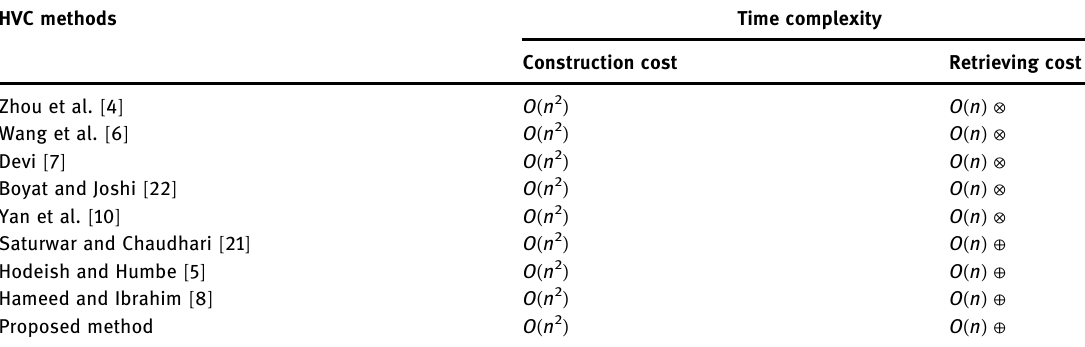
Table 6: Comparison between the proposed OCHVC scheme and related methods based on time